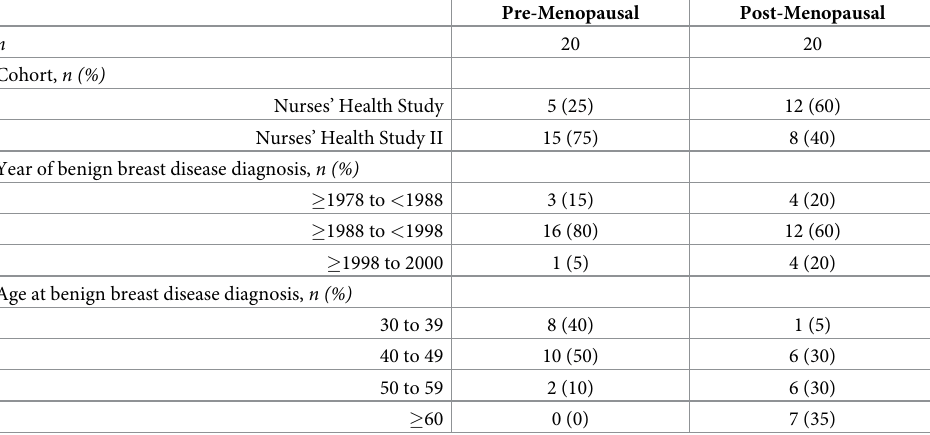
Table 1. Demographic table of 40 participants used to validate the automated measures of TDLU